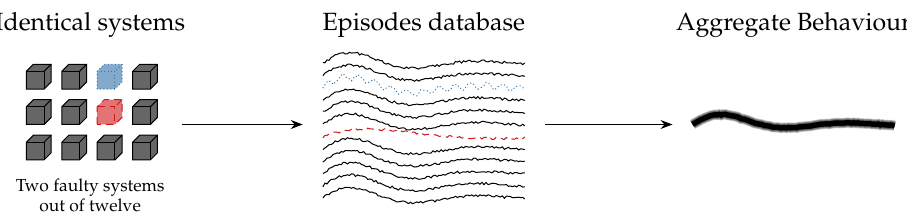
Figure 2. Effect of faulty systems in consensus-based methods. If a small number of systems using in training are faulty, their contributions will be diluted among the ones by correctly operating